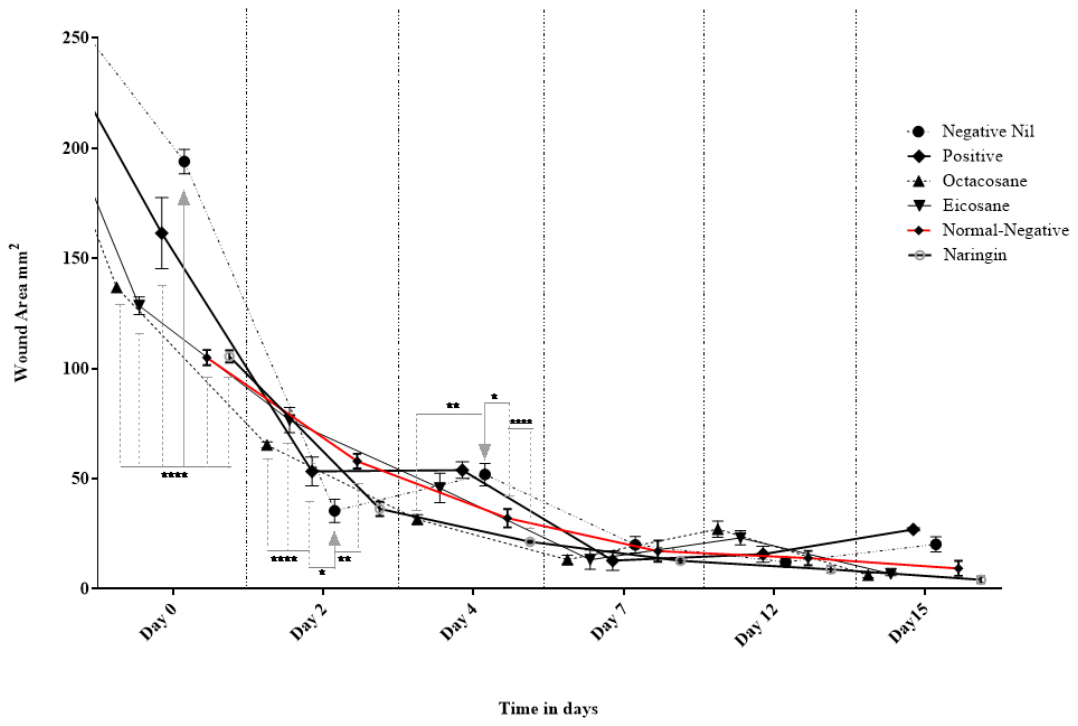
Figure 4. Effect of Naringin, Eicosane and Octacosane treatments on the wound area of diabetes- induced animals (mm 2 ). * p < 0.05, ** p < 0.01, **** p < 0.0001.